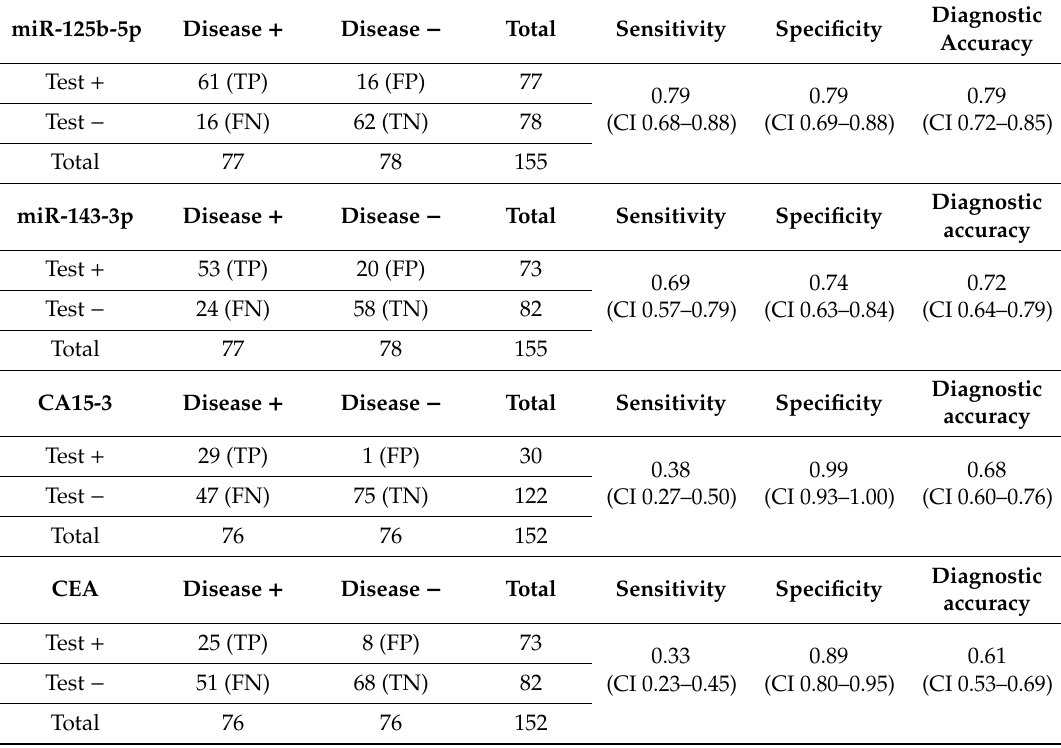
Table 3. Diagnostic accuracy of the indicated circulating